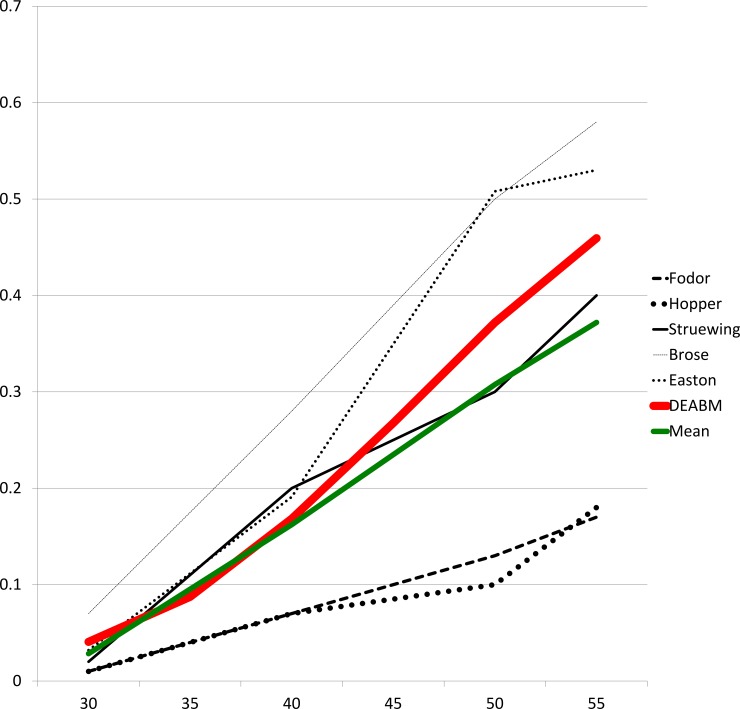
Cumulative cancer incidence over time of BRCA-1 mutated simulations in the Duct Epithelium Agent-based Model (DEABM) is compared to the results of five published studies of epidemiologic data.The cumulative incidence generated by the DEABM over 3,000 simulations was 45.9% by age 54 (95% CI 44.1–47.7%), a figure that fell within the range of published data (18%-58%) and compared favorably to the mean of the five studies (37.2%).